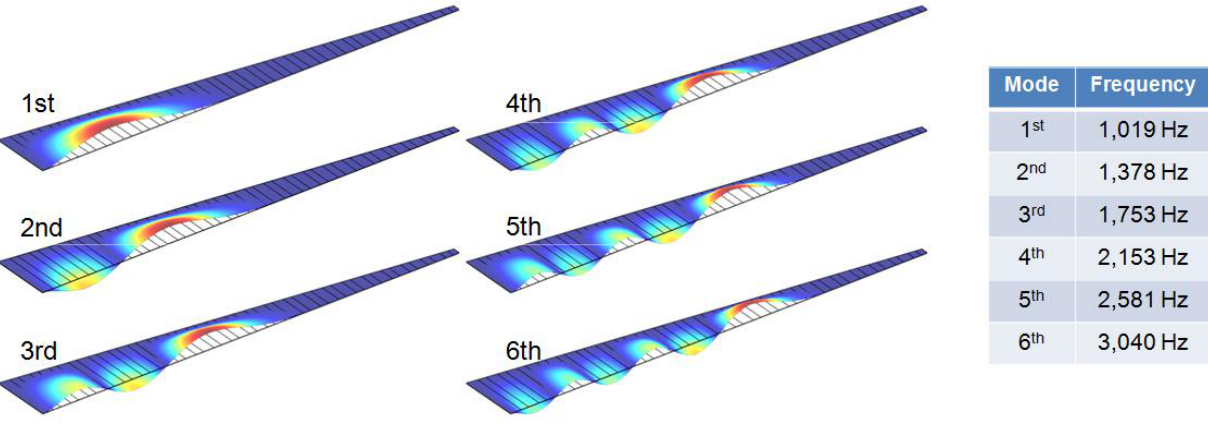
Figure 3. Resonance peak simulation results with mode analysis